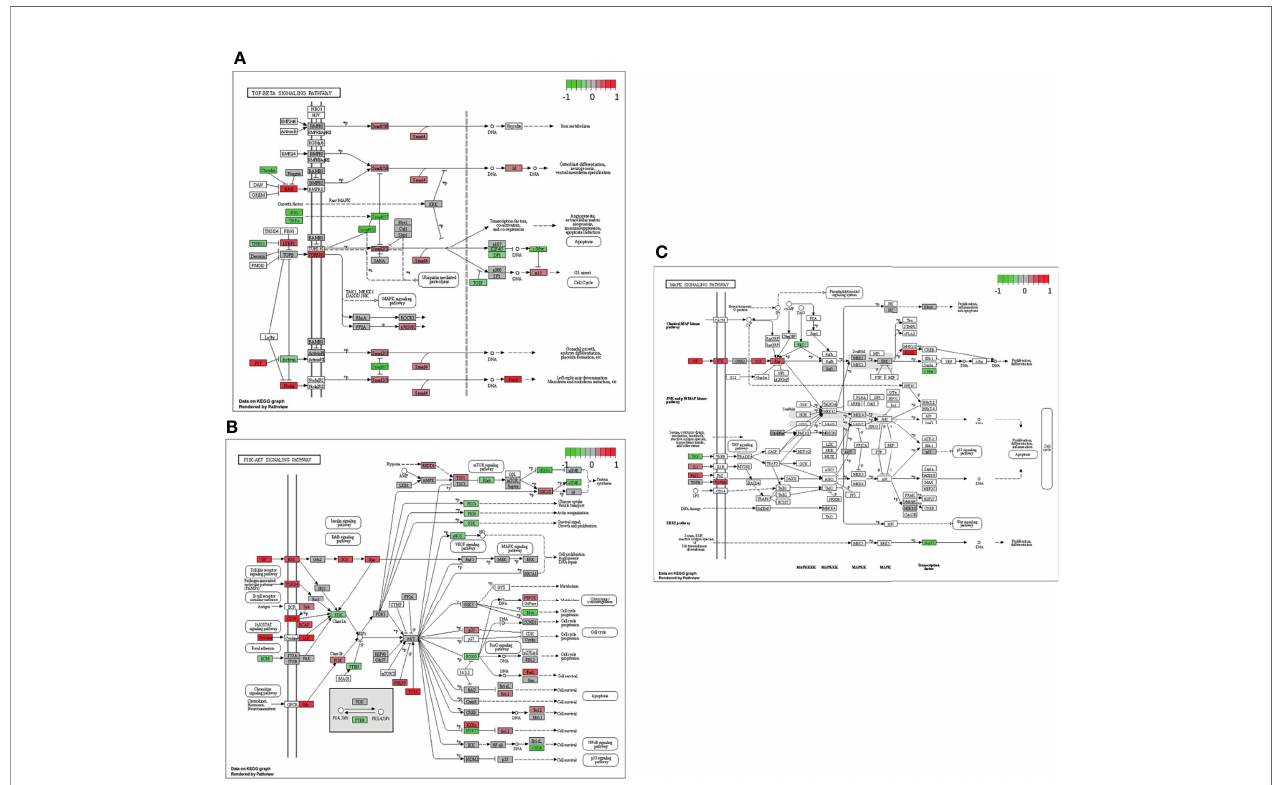
FIGURE 5 | Genes expressed in association with the TGF- b (A) , PI3K-Akt (B) and MAPK (C) signaling pathways and therapy outcome in HGSOC. The color code indicates at differential gene expression whether the patients did not (red) or did respond well to chemotherapy (green). This molecular network map stems from the Kyoto Encyclopedia of Genes and Genomes (KEGG)